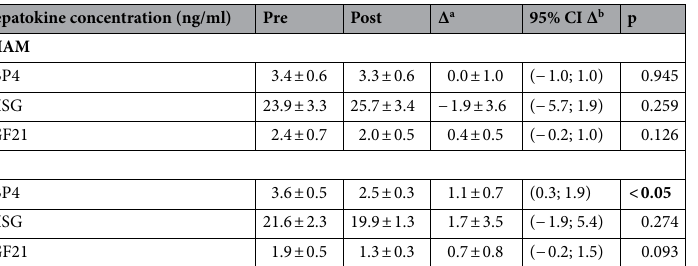
Table 2. Comparison of hepatokines: retinol-binding protein-4 (RBP4), α-2-HS-glycoprotein (aHSG/ fetuin-A) and fibroblast growth factor 21 (FGF21) serum levels in blood of Zucker (Crl:ZUC(ORL)-Lepr fa ) rats before and 12 weeks after control (SHAM) and ileal transposition (IT) surgery. The CRP results were significantly different before surgery (Table 1: pre IT vs. pre SHAM—24.4 ± 2.3 vs. 16.0 ± 2.8, p < 0.001) thus the values for this parameter are not compared here. The results are presented as mean ± standard deviation. Significance for p-value was set at < 0.05. a Δ—difference. b CI Δ—95% coincidence interval.